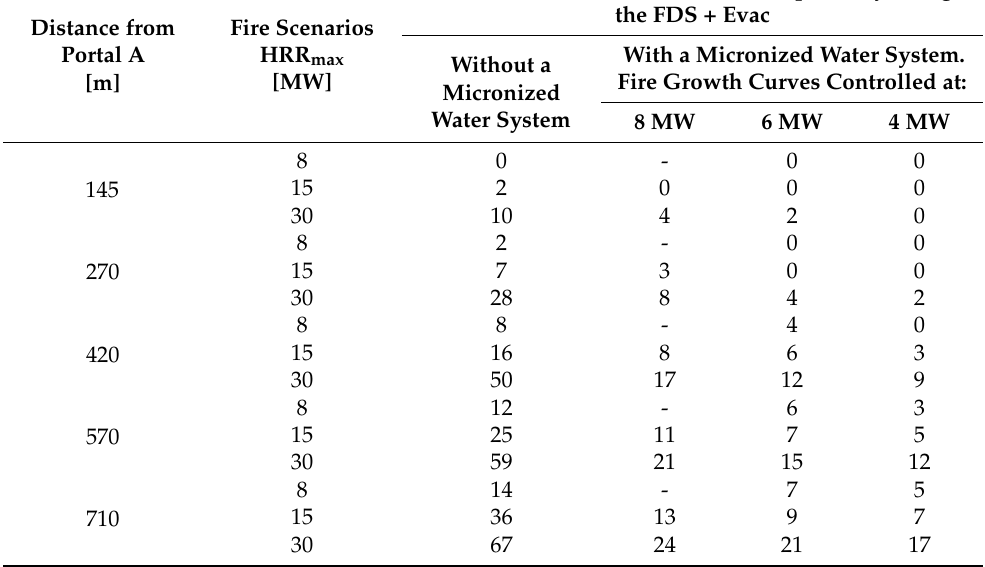
Table 1. Number of potential fatalities computed by using the FDS + Evac with and without a micronized water